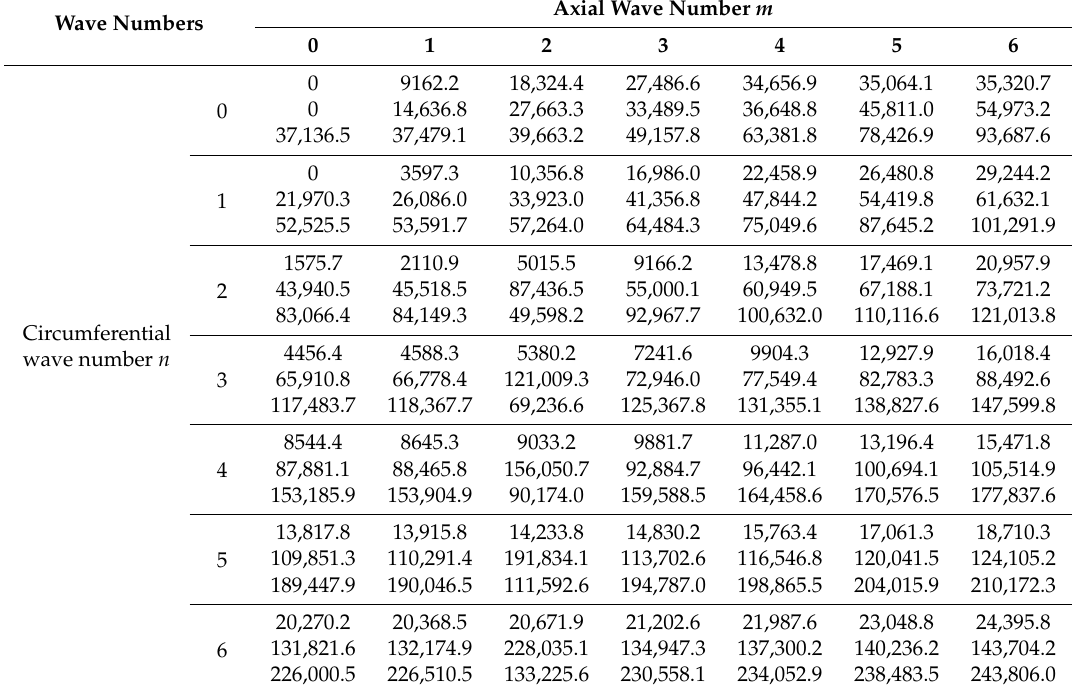
Table 2. Natural frequencies of unmanned underwater vehicle (UUV) body structure ω